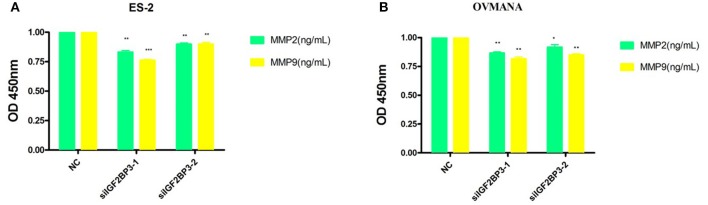
The effect of siIGF2BP3 on MMP2 and MMP9 levels in both ES2 and OVMANA cell supernatants. (A) Bar chart of ELISA analysis of MMP2 and MMP9 levels in ES2 cell supernatant. (B) Bar chart of ELISA analysis of MMP2 and MMP9 levels in OVMANA cell supernatant. Results were obtained from three independent experiments, *P < 0.05, ** P < 0.01 and *** P < 0.001, compared with NC.